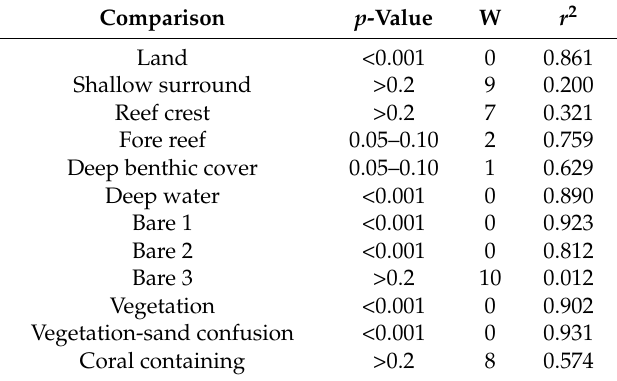
Table 9. Wilcoxon signed-rank test for paired samples results ( p -value, W) and linear intercorrelation strength ( r 2